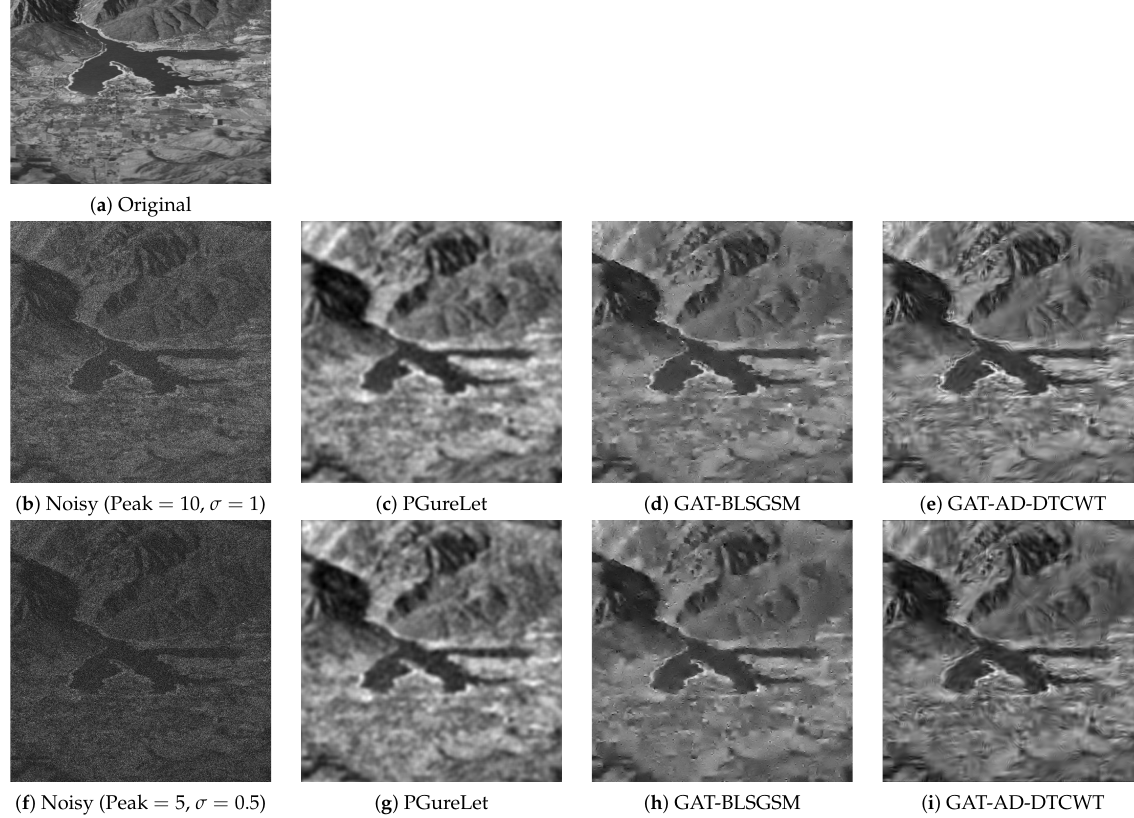
Figure 10. Poisson–Gaussian denoising results on the ‘Ogden Valley’ image by various methods where noisy image is corrupted by Poisson noise at signal peak = 10 & σ = 1 (second row) and at signal peak = 5 & σ = 0.5 (third